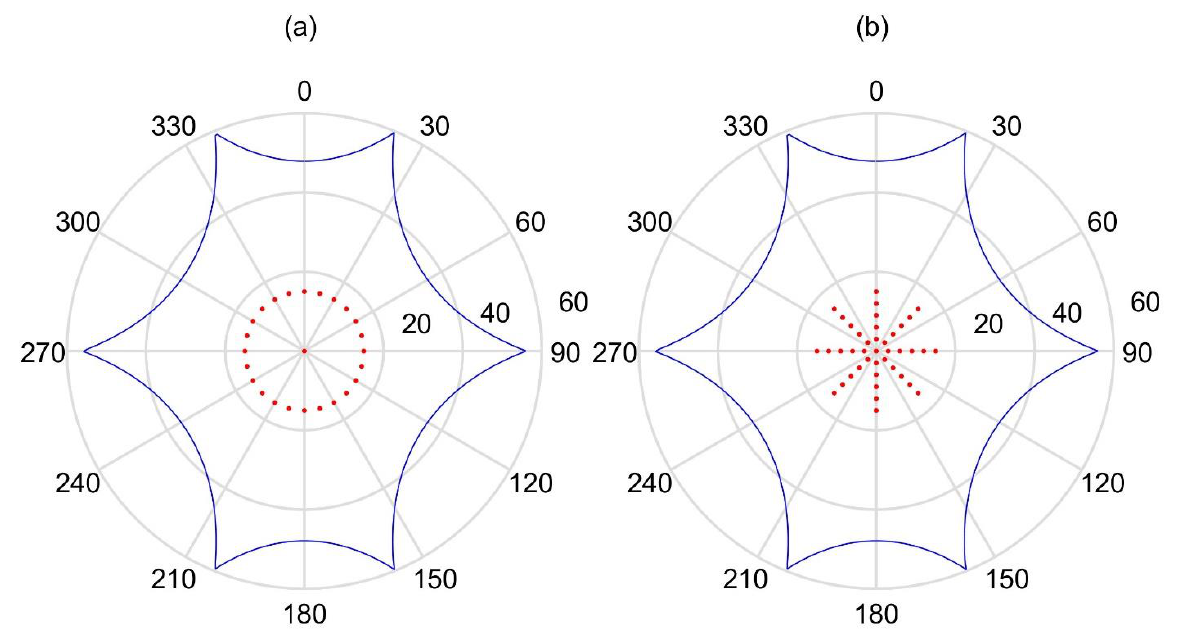
Figure 1. ( a ) Schematic of 25 beams and ( b ) schematic of 41 beams. Table 2. Signal processing parameter